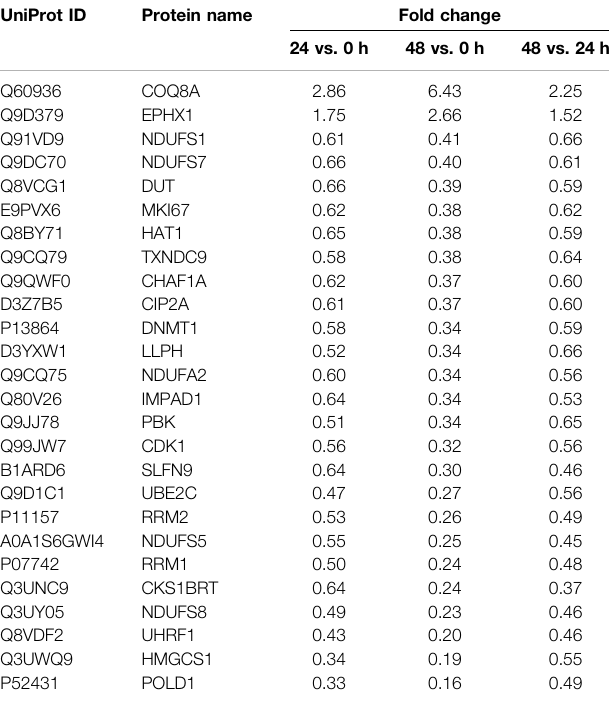
( Figure 8C ). The expression of Tyr and Mitf mRNA also increased by the treatment of fl avopiridol and OTS-964